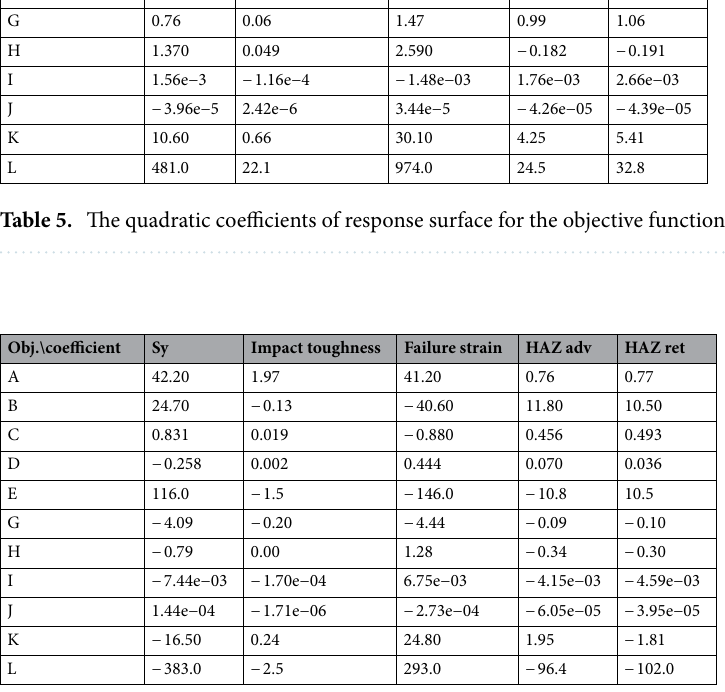
Table 6. The quadratic coefficients of response surface for the objective functions of threaded cylindrical pin.